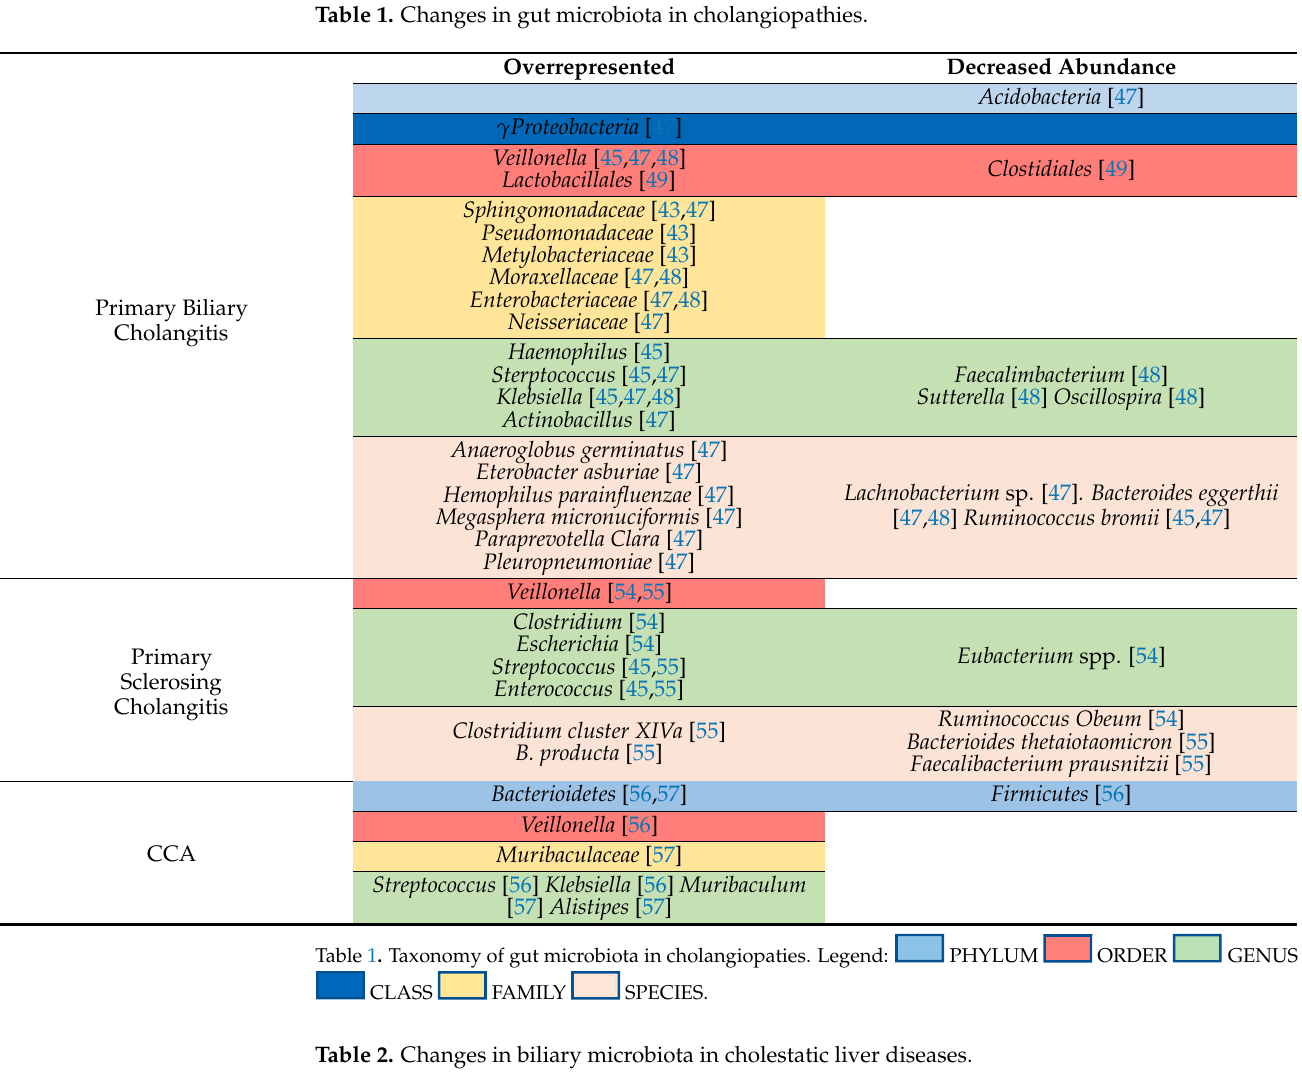
Table 1. Changes in gut microbiota in cholangiopathies.